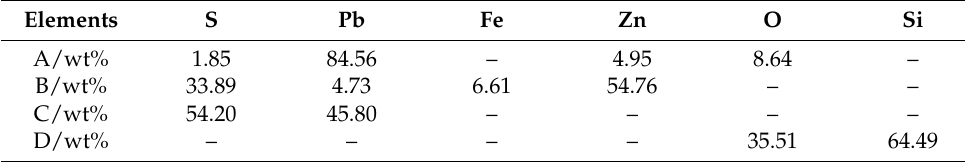
Figure 4. The EDAX spectra of the complex zinc ore.